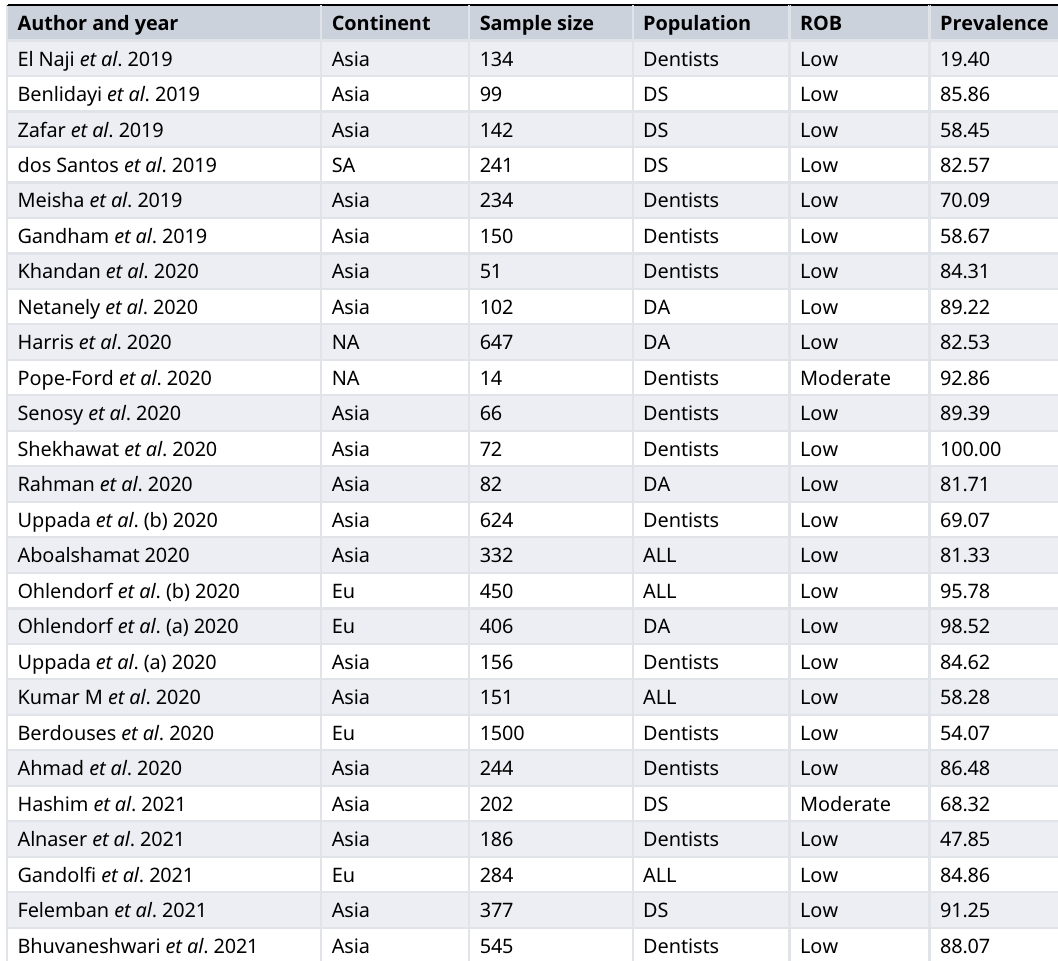
Mostofthestudiesreportedtheagedistributionoftheparticipants(n=61),while14studiesreportedonlytheagerangeof the participants. Prevalence estimates could not be calculated as there was substantial variation in age grouping.